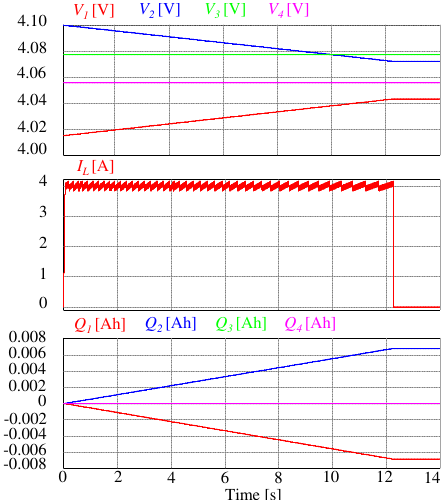
Figure 23. Equalization of a four-cell battery bank using the single inductor scheme.